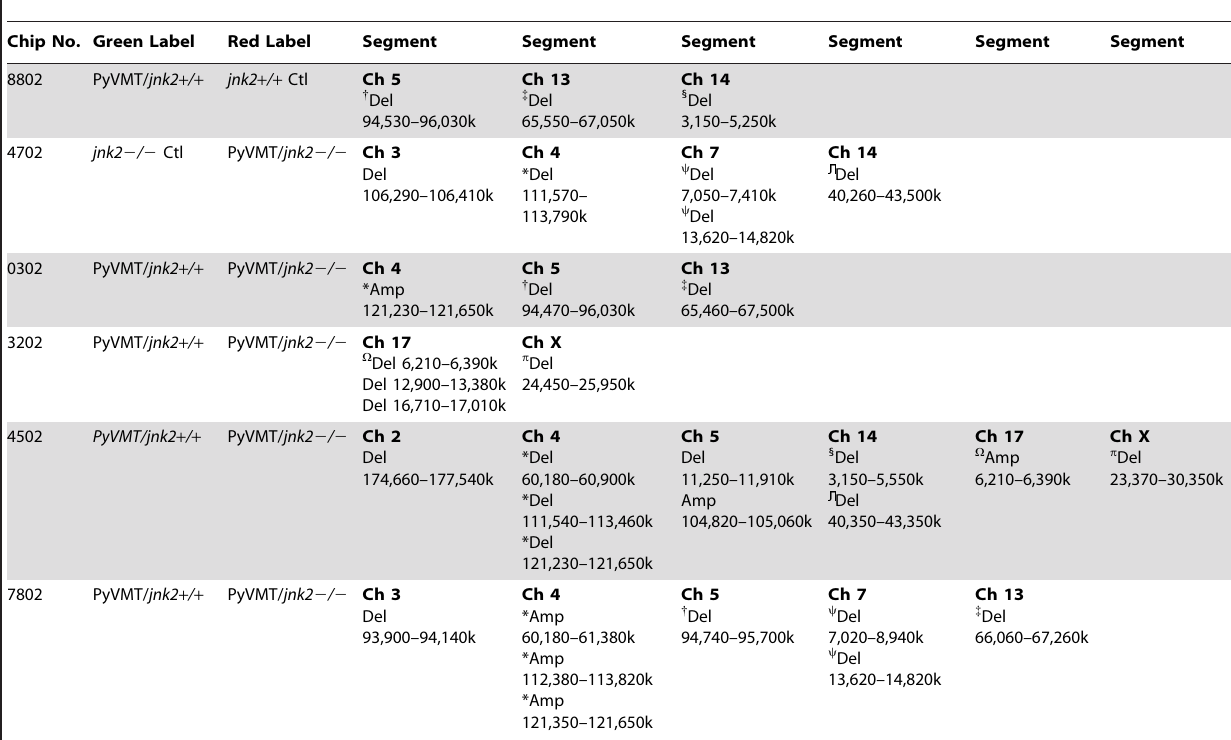
Table 1. aCGH analysis showing segmental amplifications or deletions.